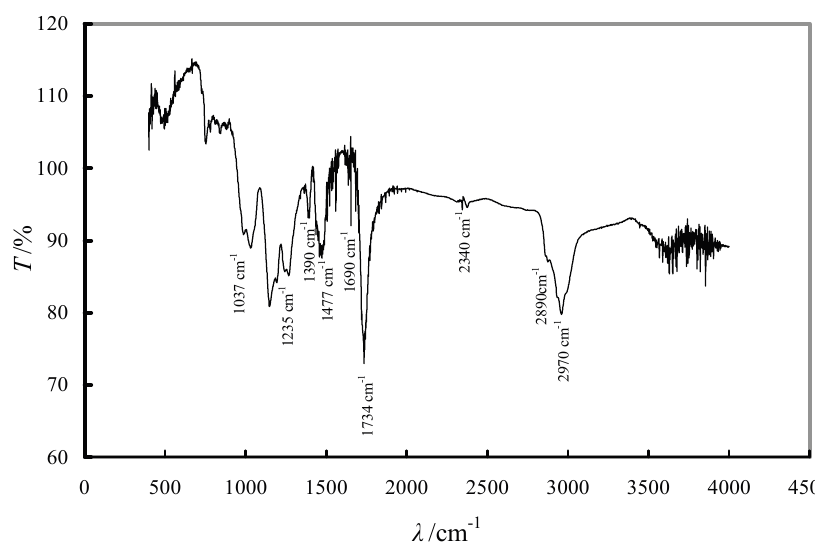
Figure 2. IR spectrum of a Fe-XAD8-DEHPA sample.